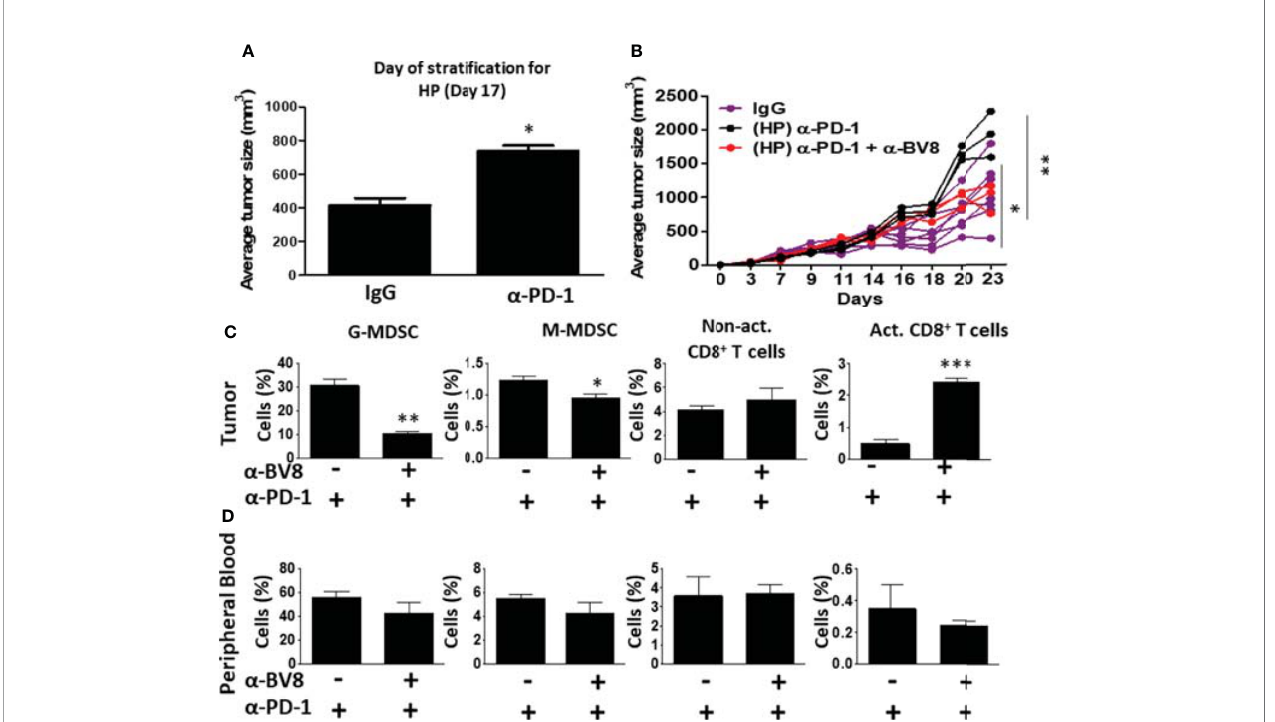
FIGURE 3 | Anti-Bv8 treatment inhibits the growth of hyperprogressive tumors following anti-PD1 therapy. (A) A subset of EMT6 tumor-bearing BALB/c mice treated with anti-PD1 shown in Figure 2 , displayed accelerated tumor growth, termed hyperprogression (HP) when compared to IgG control (n=6 mice), shown on day 17. At this time, the mice were treated with anti-PD1 in combination with anti-Bv8 or anti-PD1 as a monotherapy (n=3 mice/group). (B) Tumor growth in individual mice is shown in a spider plot. (C, D) At the endpoint, tumors and peripheral blood were harvested. Granulocytic and monocytic MDSCs (G-MDSC and M- MDSC, respectively) as well as non-activated and activated CD8+ T cells in tumor single-cell suspensions (C) and peripheral blood (D) were quanti fi ed by fl ow cytometry, and presented as the percentage from CD45+ cells. The average percentage ± SD for each cell type, is shown in a bar graph. Statistical signi fi cance was assessed using unpaired two-tailed t-test. Signi fi cant p values are shown as *p<0.05; **p<0.01;